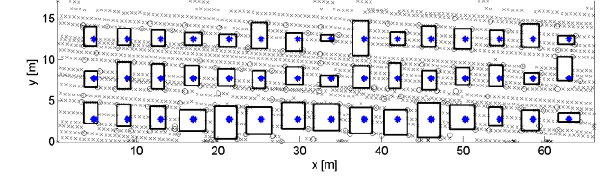
Figure 7. Point cloud (black x) of the façade shown in Figure 6. The seed points are marked with blue dots.